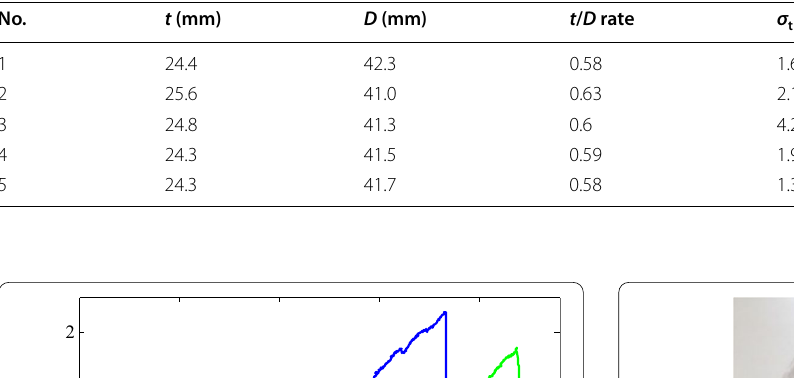
Table 2 STS test results when the water–cement rate was 0.35. No.